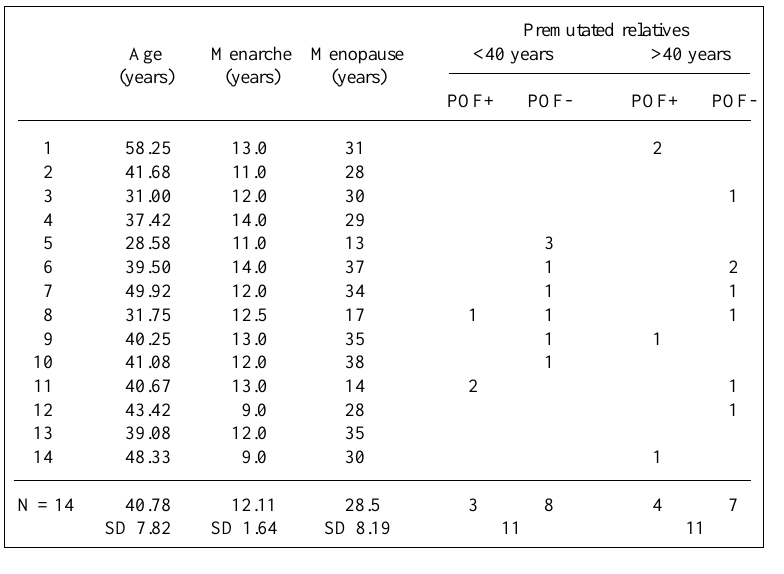
Table 2 - Premutated women with